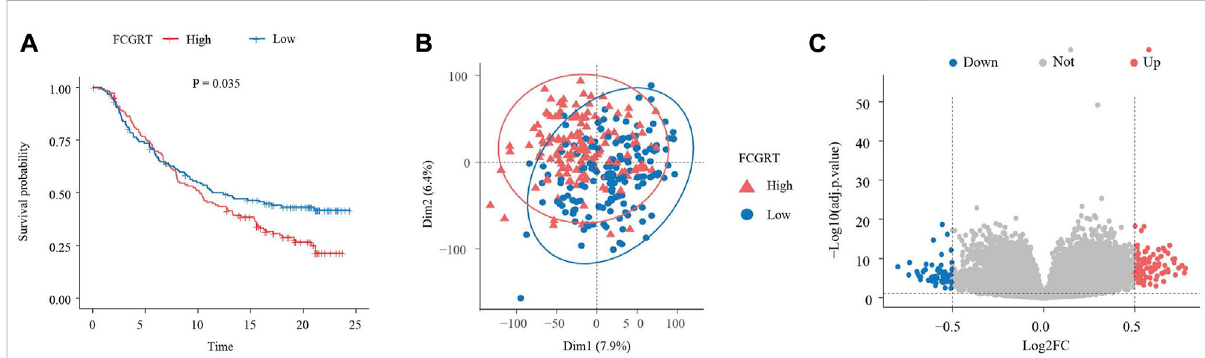
FIGURE 4 Identi fi cation of DEGs in FCGRT high and FCGRT low group (A) Kaplan – Meier survival curve of overall survival based on FCGRT expression ( p = 0.035,HR=1.245,95%CI:1.015 – 1.526) (B) Comparisonofgeneexpressionpro fi lesoftheFCGRThighandFCGRTlowgroup. (C) TheVolcanoplotof DEGs. DEGs, differentially expressed